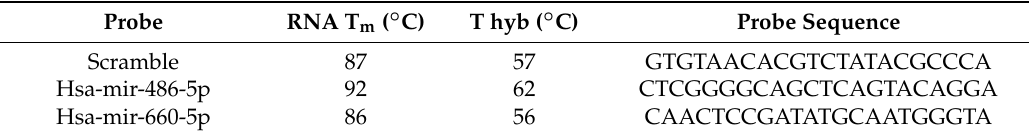
Table 1. List of detection